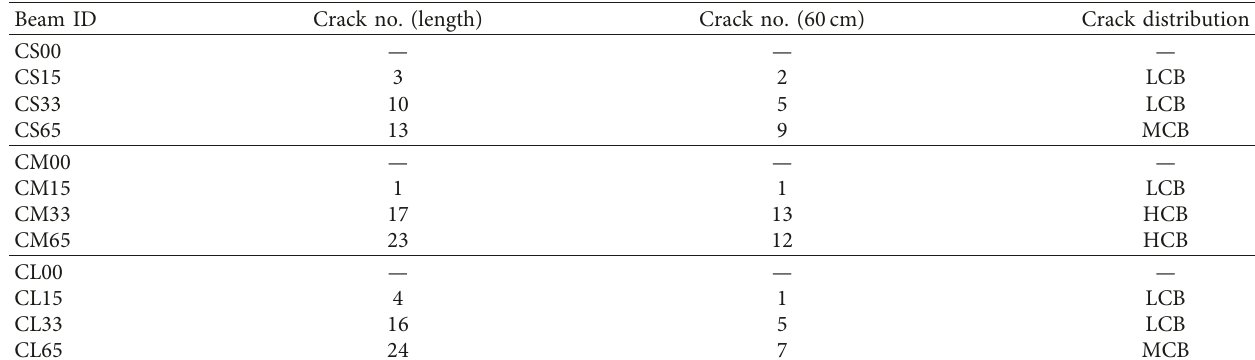
Figure 11: Crack propagation of large beams. Table 9: Number of